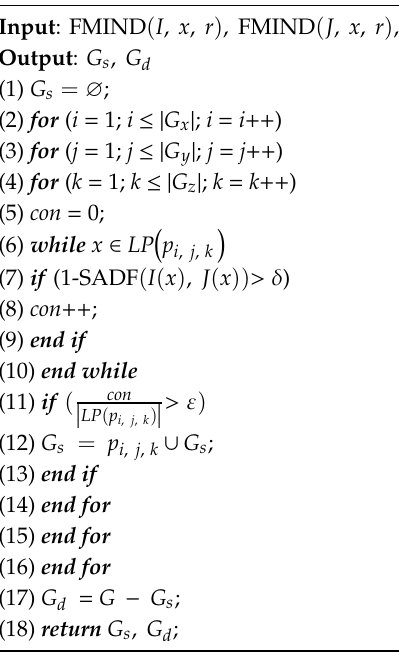
Algorithm 1. Partition of the vertex set